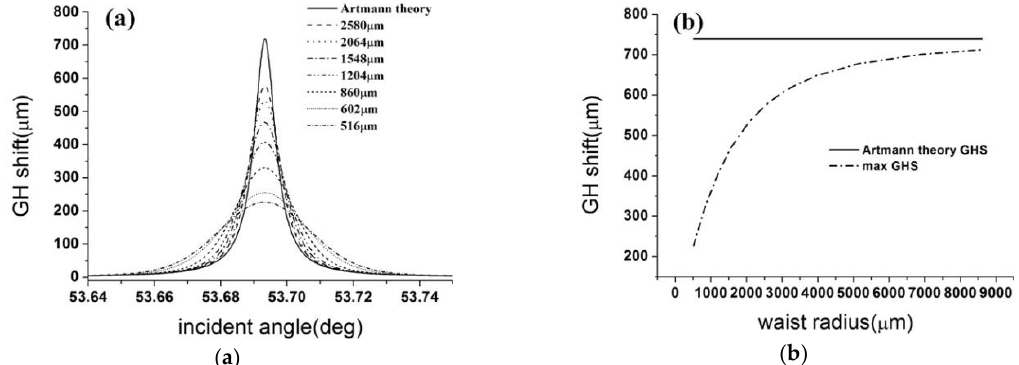
Figure 4. ( a ) GH shift vs. incident angle ( b ) The max GH shift distribution for different waist radiuses of incident beam.